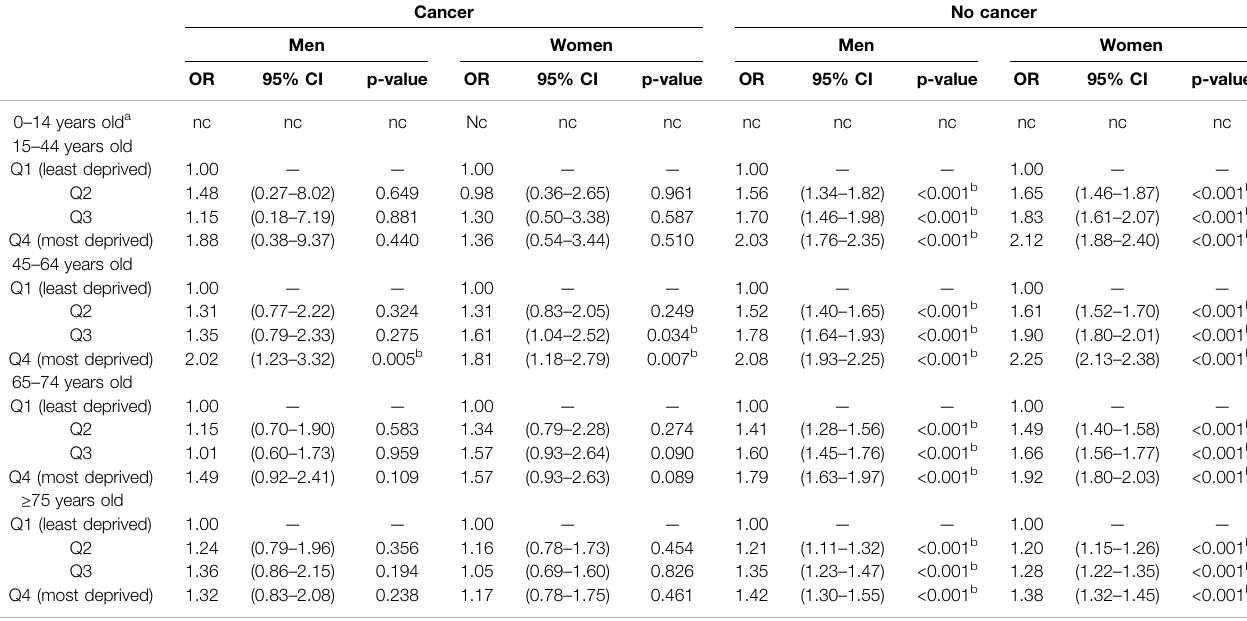
TABLE 5 | Odds ratio (OR) of weak opioids use by sex, age, composite socioeconomic index (quartiles), and cancer diagnosis adjusted for age in Catalonia,